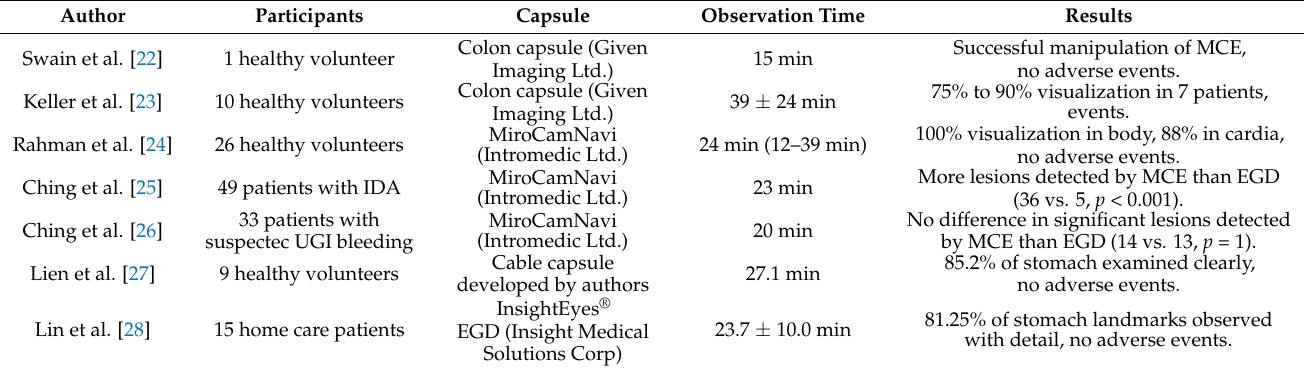
Table 3. Clinical studies using magnetic guided capsule gastroscopy controlled by an electromagnetic coil system.